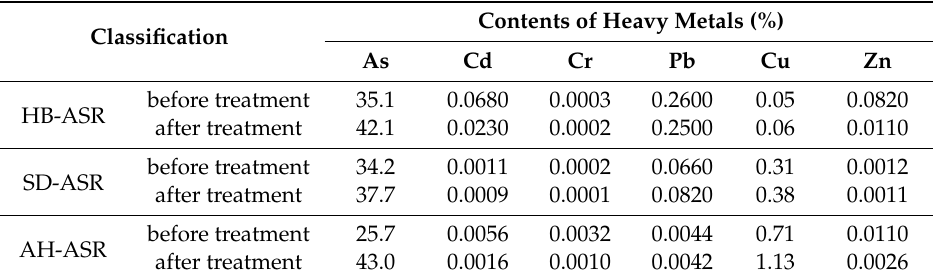
Table 4. Heavy metal contents in the raw and treated ASRs.